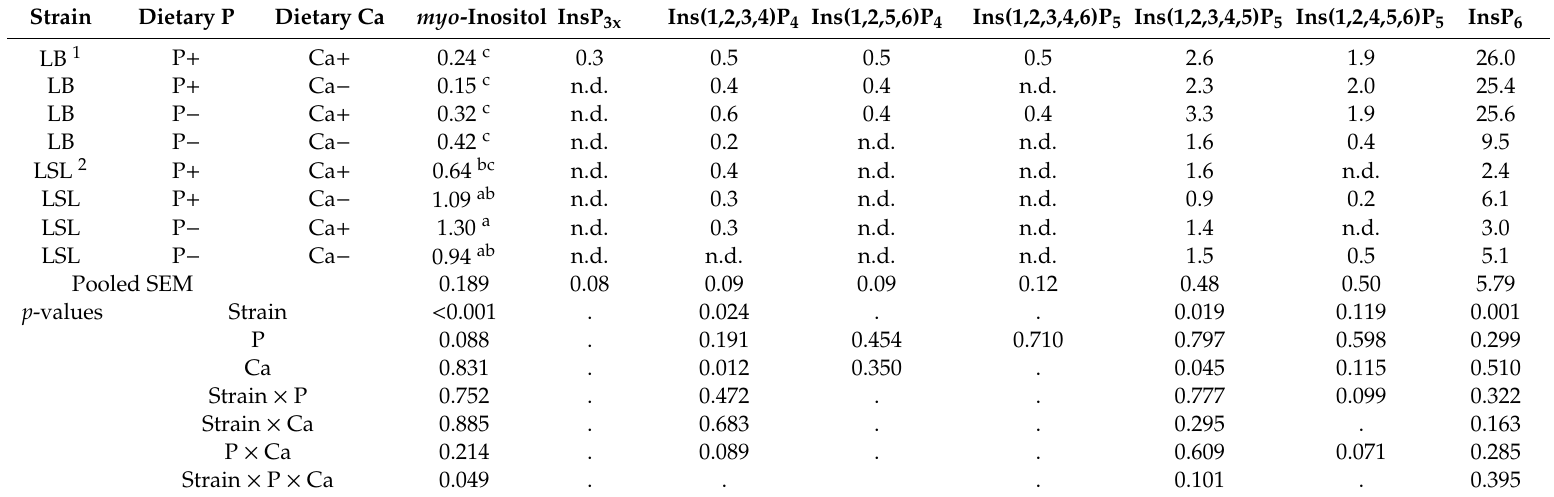
Table 6. E ff ect of strain, P, and Ca on concentrations of myo -inositol and InsP isomers in the ceca of laying hens aged 31 weeks ( µ mol / g). Strain Dietary P